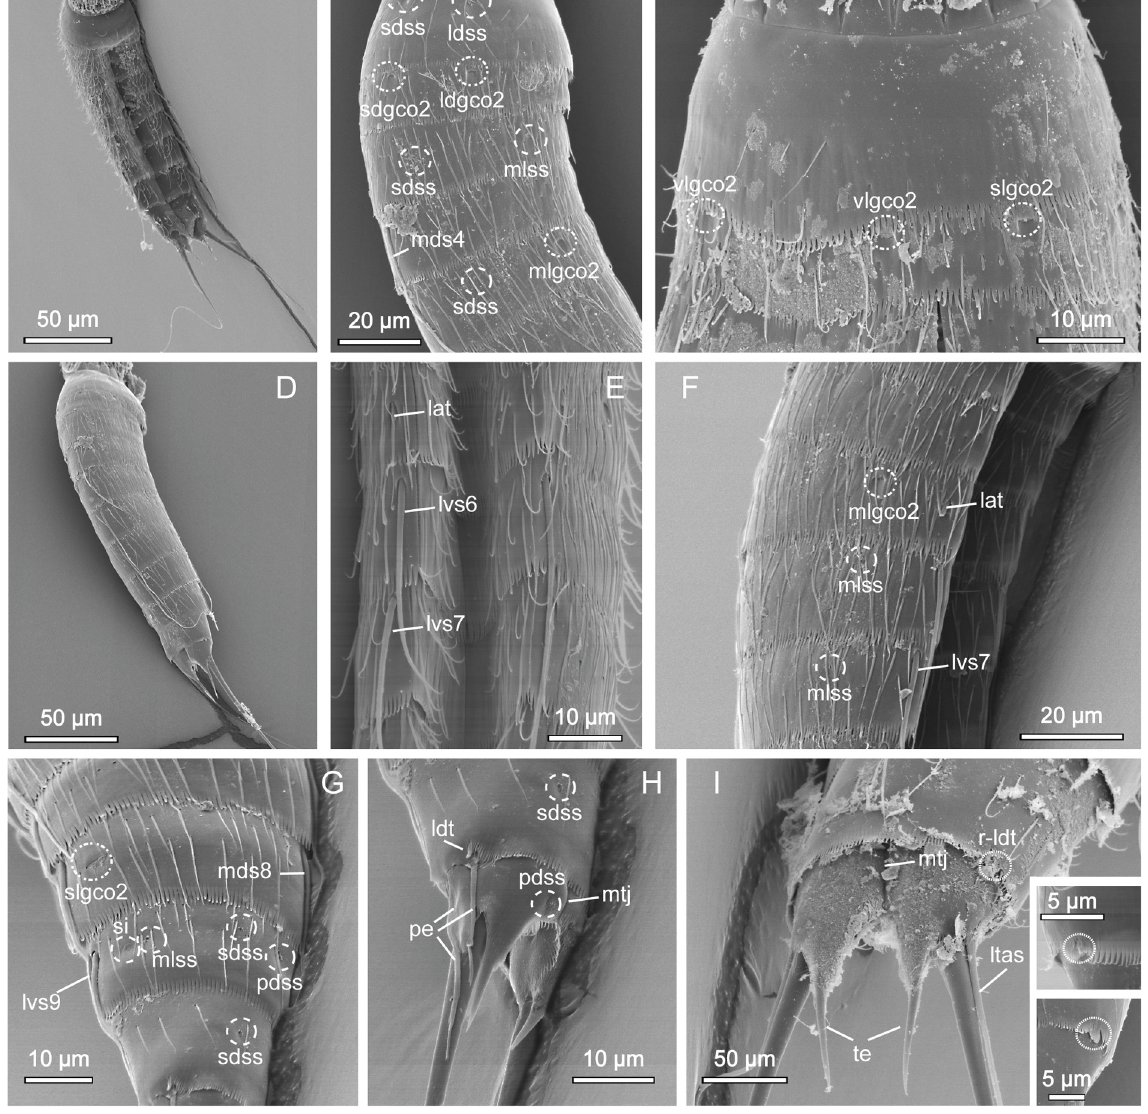
Fig. 31. Scanning electron micrographs showing overviews and details of Echinoderes galadrielae sp. nov. A . Ventral overview. B . Segments 1 to 5, dorsolateral view. C . Segments 1 to 2, lateroventral view. D . Dorsal overview. E . Segments 5 to 7, ventral view. F . Segments 4 to 7, lateral view. G . Segments 8 to 10, dorsolateral view. H . Segments 10 to 11 of male, dorsolateral view. I . Segments 10 to 11 of female, dorsal view with insets showing close-up of reduced laterodorsal tubes on segment 10. Abbreviations: see Material